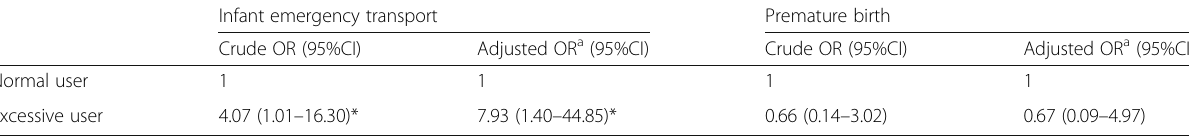
Table 4 Infant emergency transport and premature birth differences between the normal and excessive use groups Infant emergency